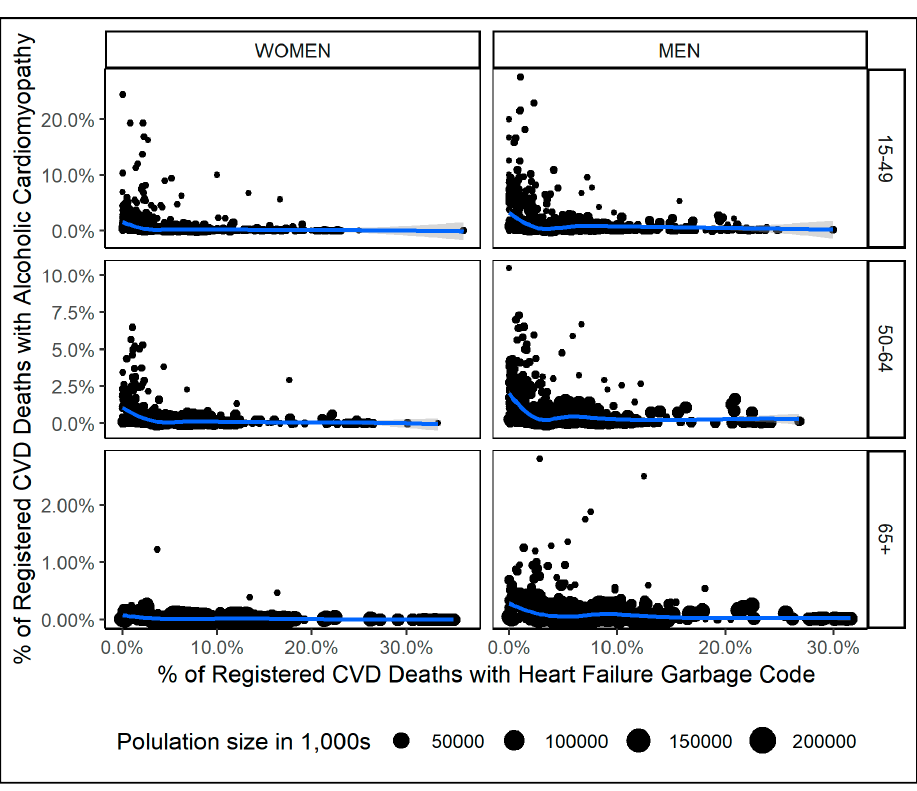
Figure A1. Scatter plots of % HF garbage code deaths and % ACM deaths among all CVD deaths by sex and age group; the blue line denotes a weighted smoothing function of the two